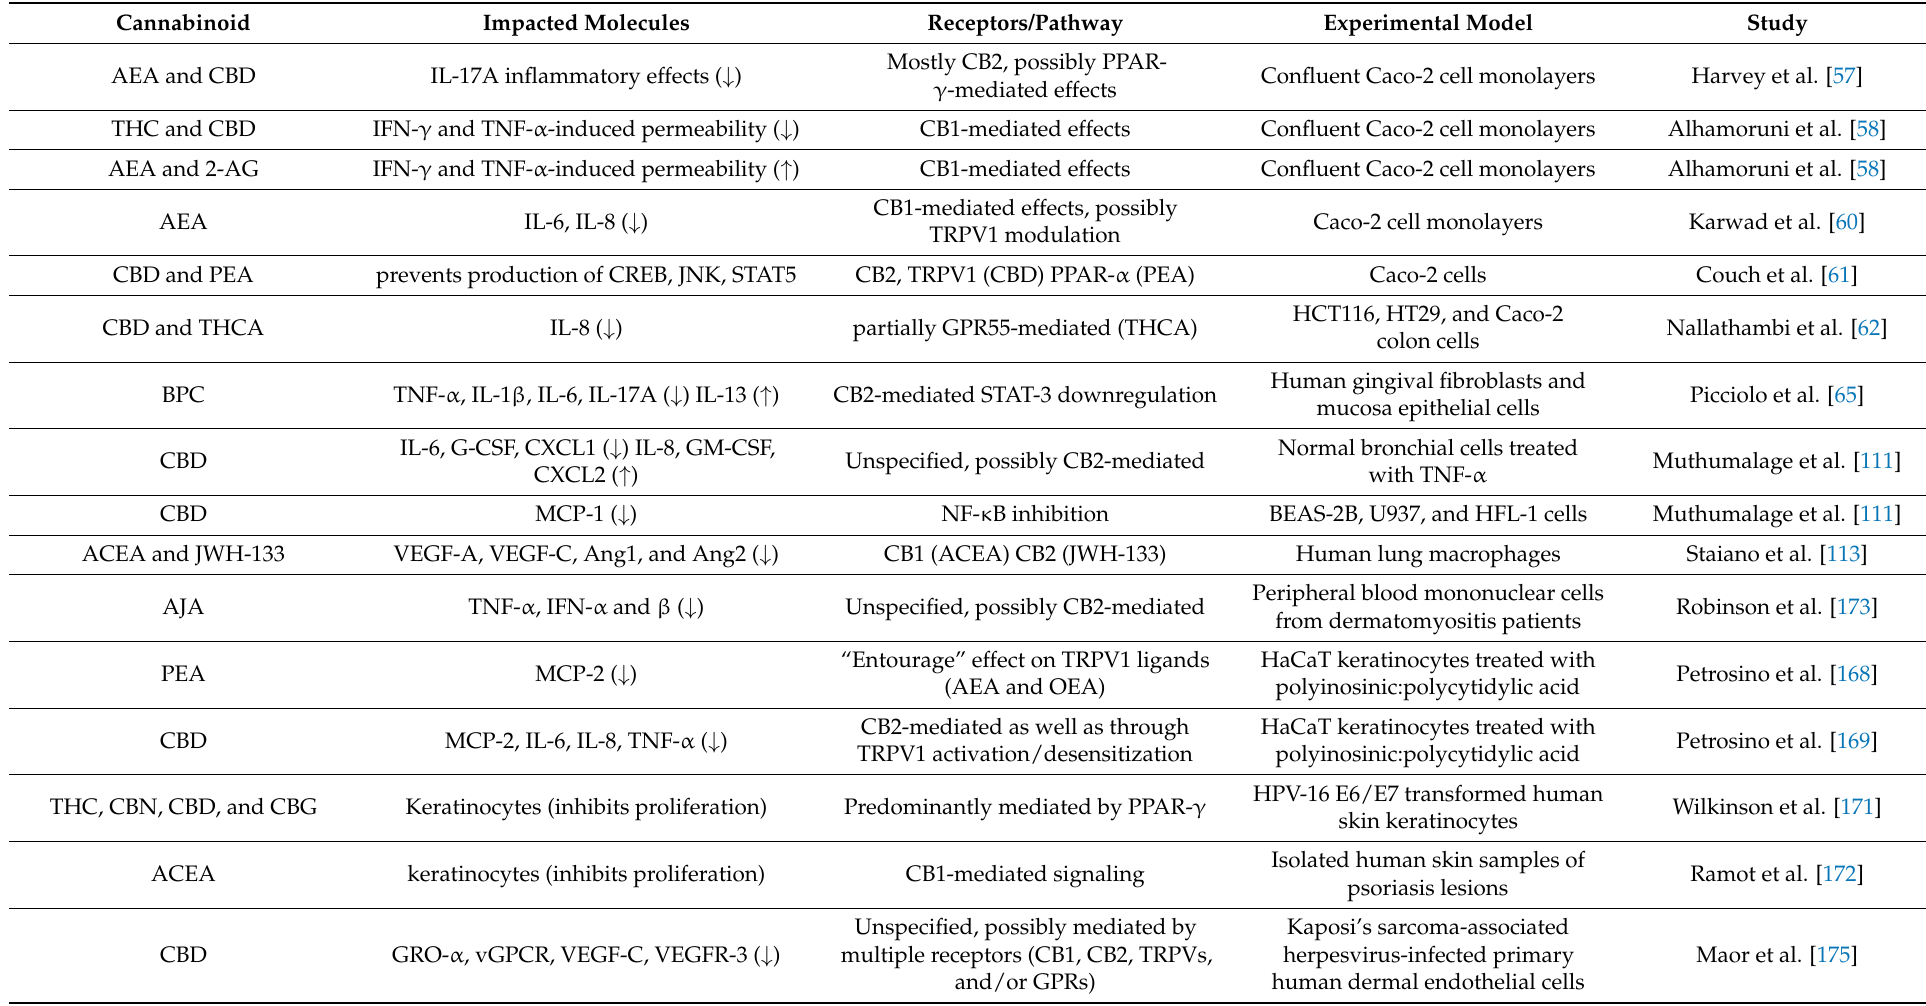
Table 1. The roles of cannabinoids in inflammatory conditions of the gut-lung-skin barrier demonstrated in in vitro